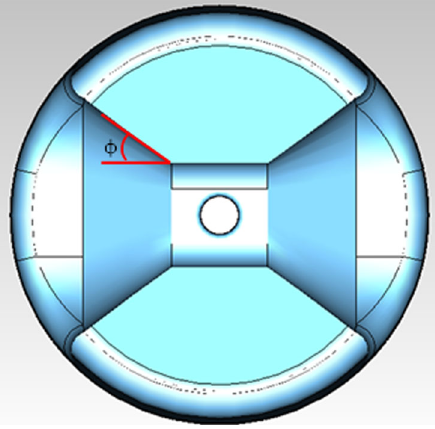
FIG. 22. End view of a single spoke showing the spoke angle (cid:2) .